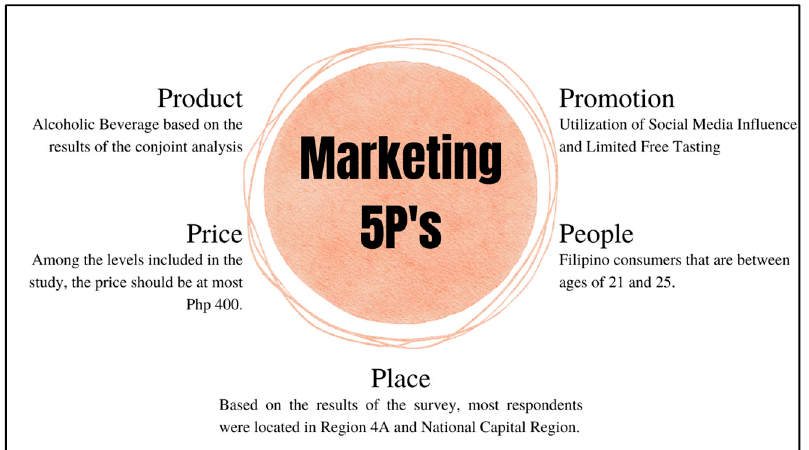
Figure 2. Marketing 5P’s.